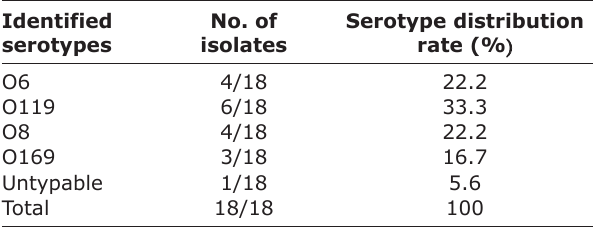
Table-3: Serotyping of Escherichia coli isolates. Identified serotypes